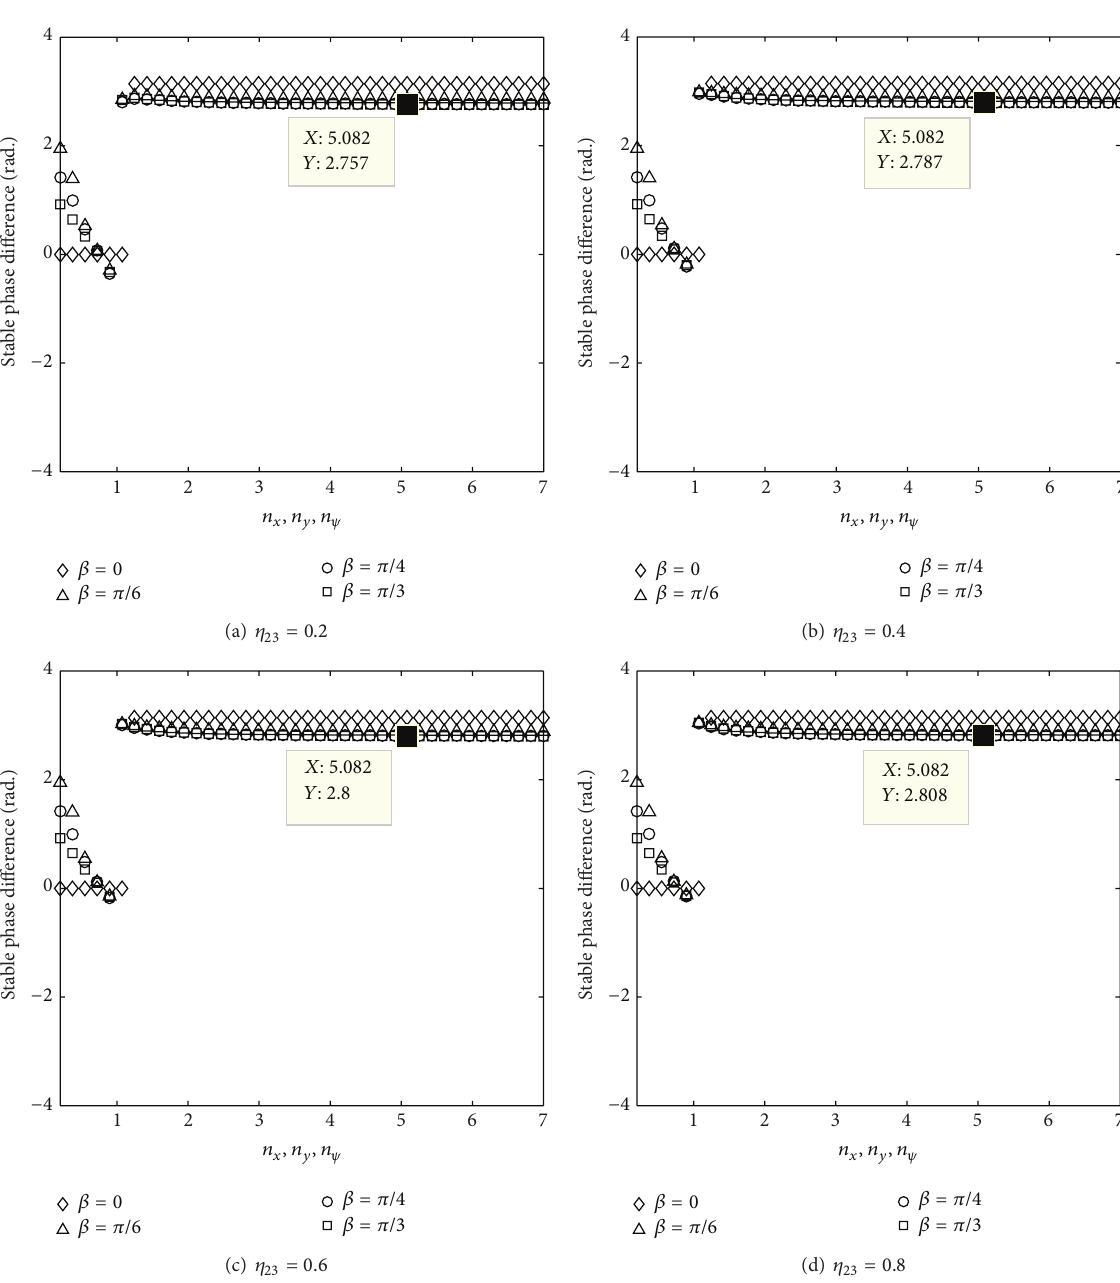
𝑛 ≥ 2.0 ), and system of after-resonance coupled with 1